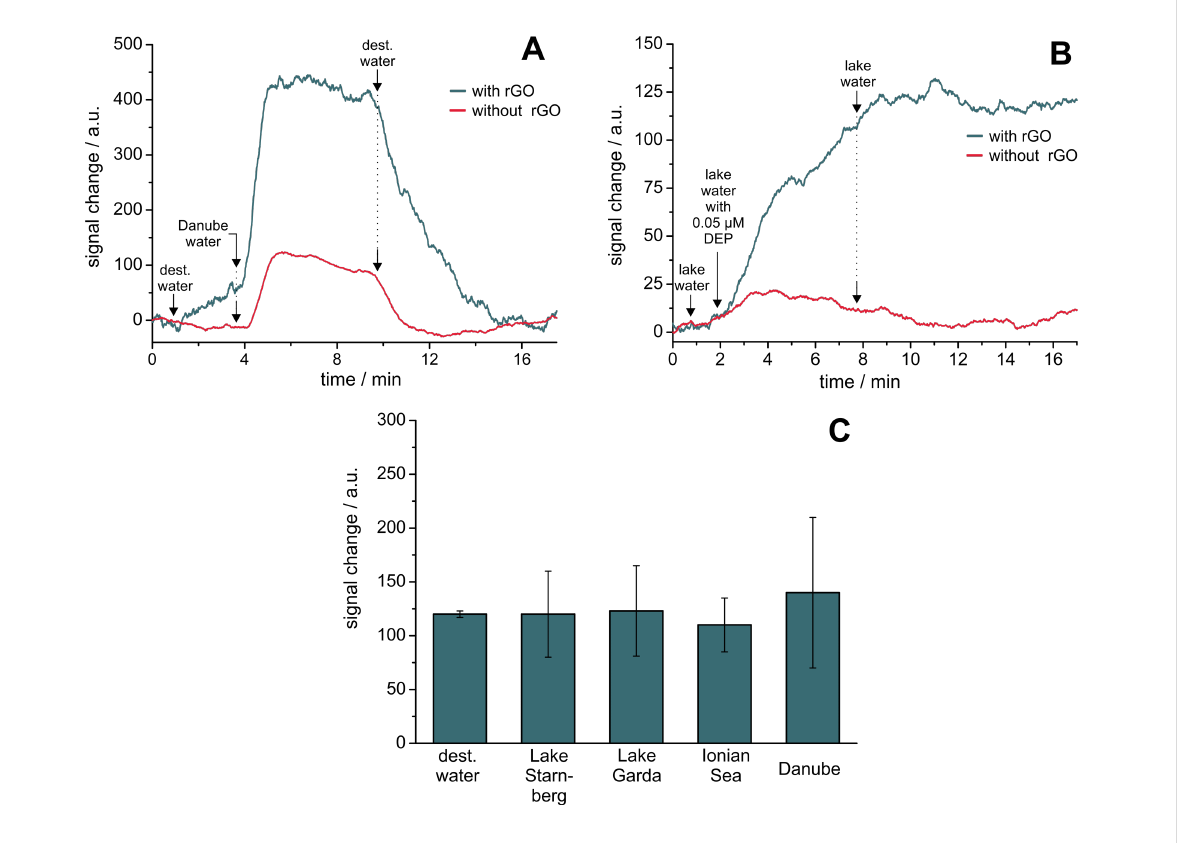
Figure 7: Exemplary signal traces at a constant angle for a nanohole array with D / P = 0.43 (A) with and without rGO receptor layers recorded for the addition of Danube water and recovery with the addition of distilled water, and (B) of Lake Starnberg water followed by the same water spiked with 0.05 µM DEP and subsequent washing with original Lake Starnberg water again. (C) Signal change for various water samples for a nanohole array ( D / P = 0.43) with rGO. Samples were spiked with 0.05 µM